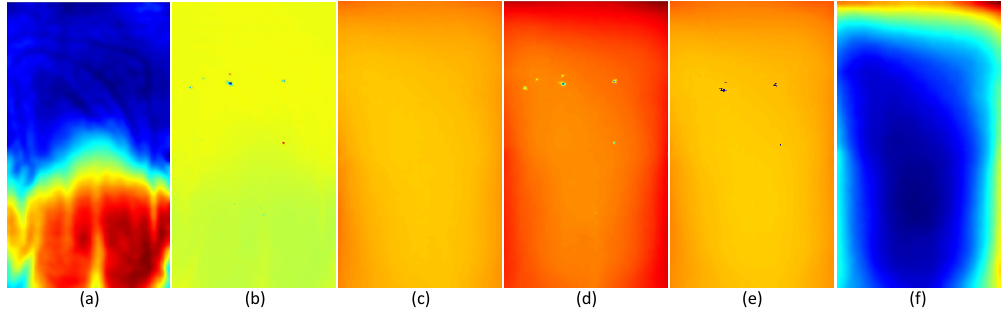
Figure 8. ( a ) PCA result (first eigenvector) using bilateral filtering and hole-filling; ( b ) PCA result (erroneous) without using bilateral filtering and hole-filling; ( c ) example input depth image without any holes; ( d ) reconstruction results of ( c ) using the incorrect PCA results shown in ( b ); ( e ) example input depth image with few holes; ( f ) reconstruction results of ( e ) using the PCA results shown in ( a